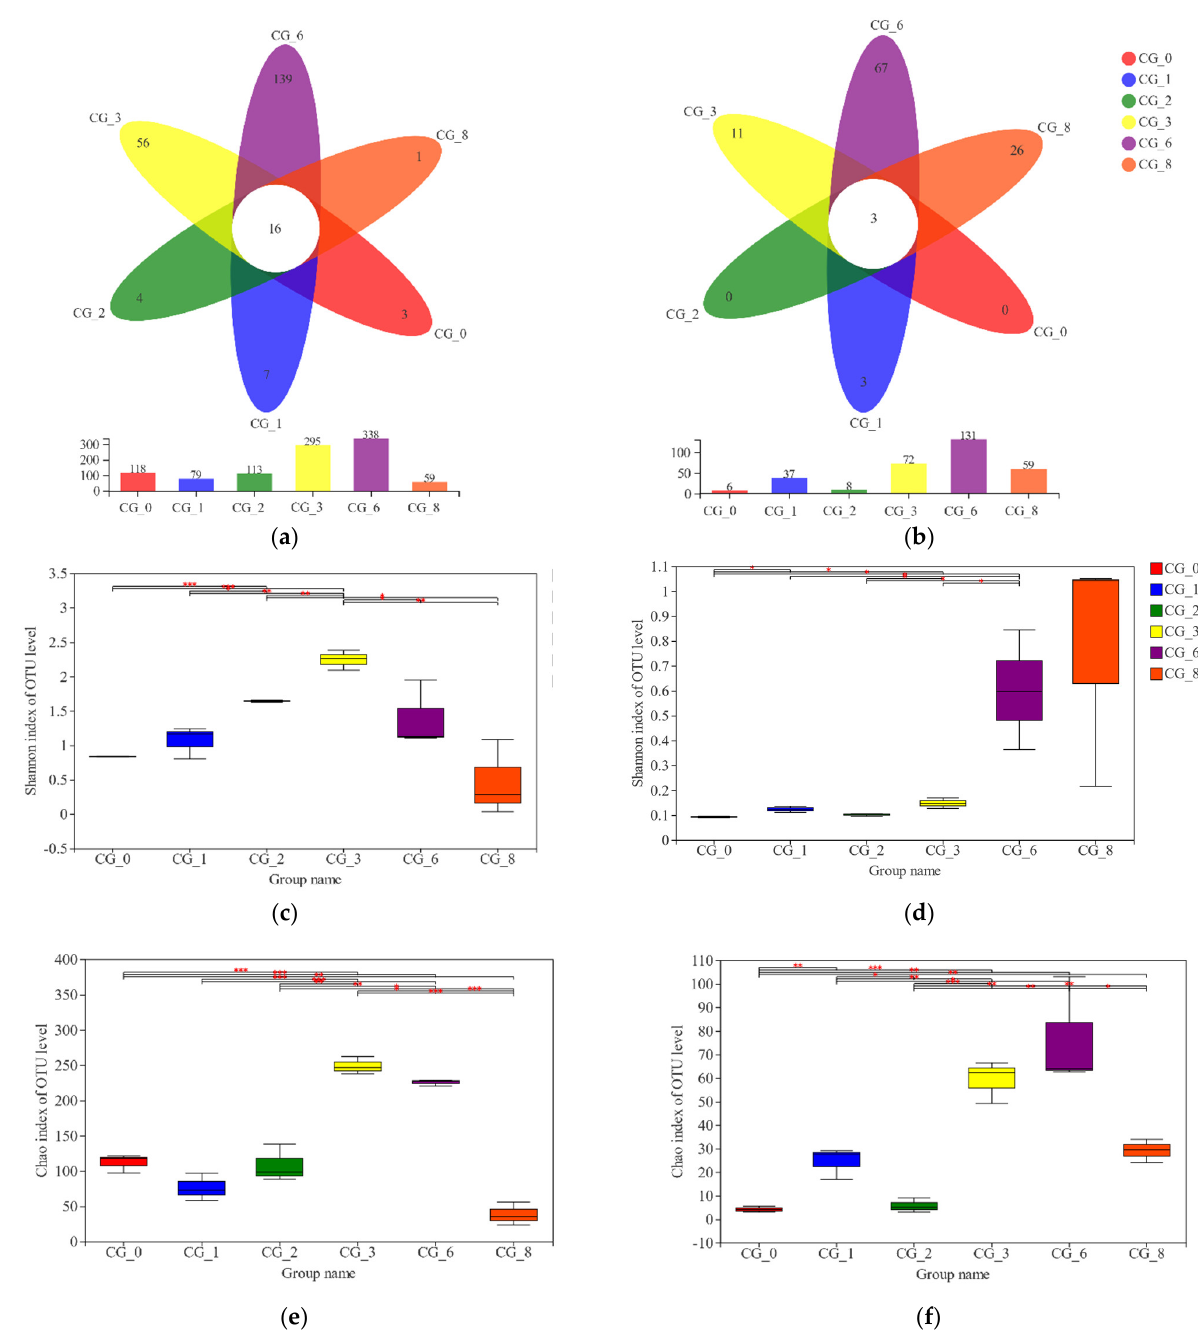
Figure 2. α- diversity analysis of bacterial ( a , c , e ) and fungi ( b , d , f ) of Caishiji soybean paste at different fermentation stages. (0.01 < p ≤ 0.05 marked as *, 0.001 < p ≤ 0.01 marked as **, p ≤ 0.001 marked as ***).